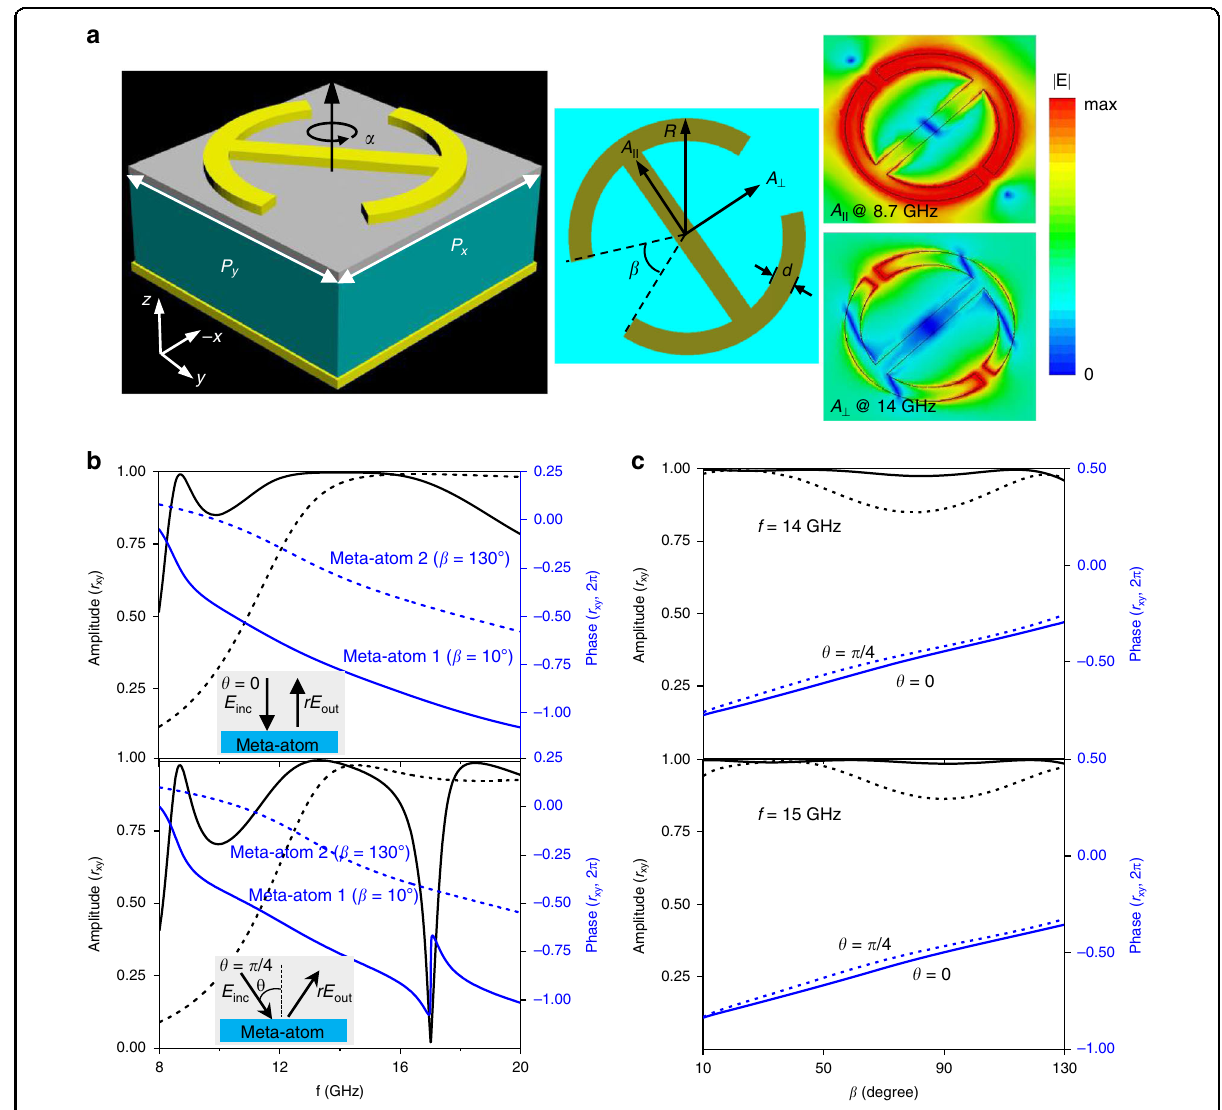
Fig. 2 Design and characterization of the meta-atom for our metasurface cloak. a Layout of the re fl ection meta-atom with electric- fi eld distributions corresponding to dual modes at 8.7 and 14 GHz shown in the inset. The anisotropic metal – insulator – metal meta-atom composed of an ABS-M30 plate sandwiched by top quasi-I-shaped metallic patterns oriented along α = 45° and bottom- fl at ground. b Numerically calculated cross-LP re fl ection amplitude and phase spectrum for meta-atoms of β = 10° (solid line) and β = 130° (dashed line) under incidence angle of θ = 0 (top panel) and θ = π /4 (bottom panel). c Numerically calculated cross-LP re fl ection amplitude and phase versus β under θ = 0 and π /4 and frequency of 14 (top panel) and 15 GHz (bottom panel). The detailed geometric parameters are p x = p y = 5.5 mm, d = 0.4 mm, and R = 2.2